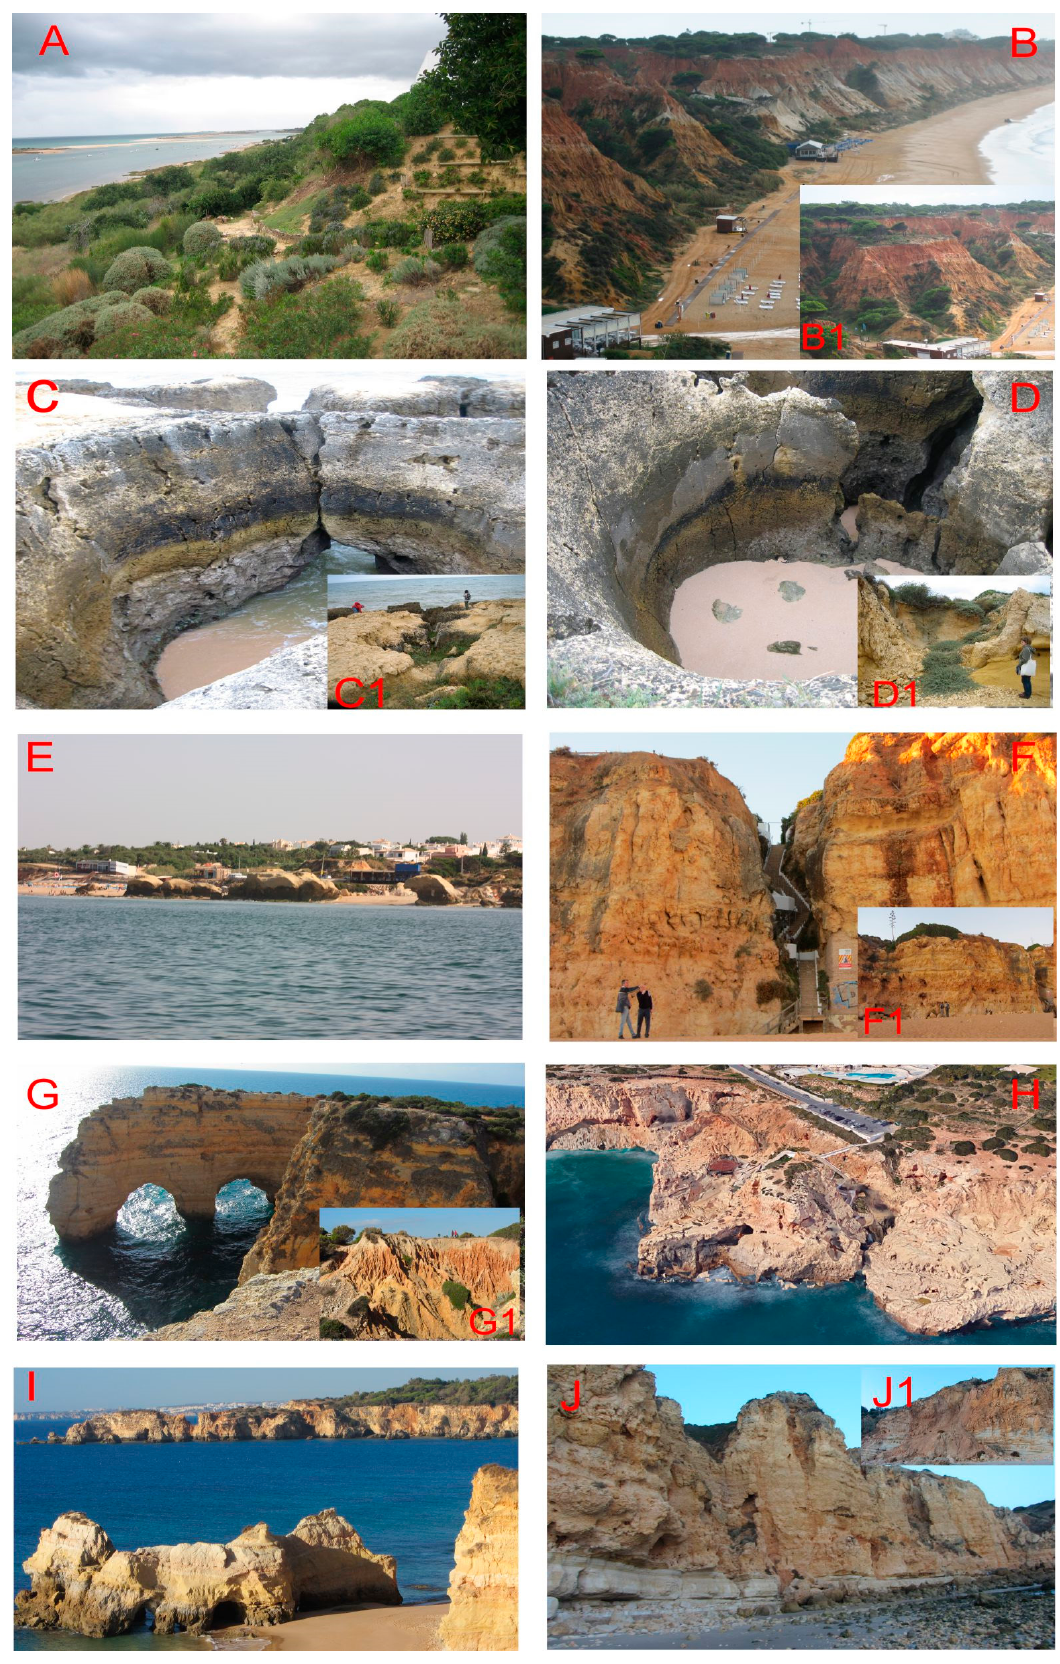
Figure 6. Geomorphological features of the selected sites. ( A ): Site 1 (Cacela); fossil cliff, protected by barrier islands and lagoons. ( B ): Site 2 (Olhos de Agua); panoramic of the sandy cliff. ( B1 ): Detail, with a gravitational slip. ( C ): Site 3 (S. Rafael-Castelo). West of São Rafael beach: Algares, dry and connected to the sea; lapiaz developed on the surface. ( C1 ):